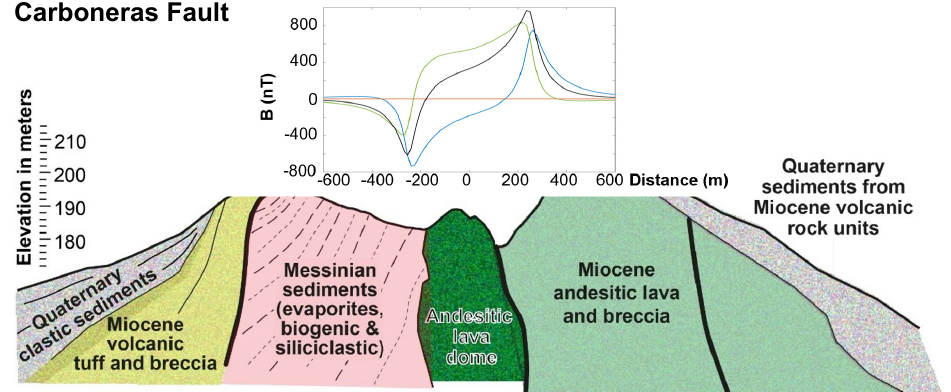
Figure 20. Interpretation of the area of study (the Carboneras Fault) as a northern area associated with the different Messinian sedimentary events, including the evaporites corresponding to the Messinian salinity crisis, which is flanked by the uplifted layer of Miocene tuff and breccia and flanked by the retreated sedimentary layer of the Plio–Quaternary. The synthetic field is calculated by the simplified model of a cylindrical dome of 250 m radius, with a susceptibility of χ = 10 − 2 SI and a natural remanent magnetization of (Mx, My, Mz) = (1, 0, 1.5) A/m.